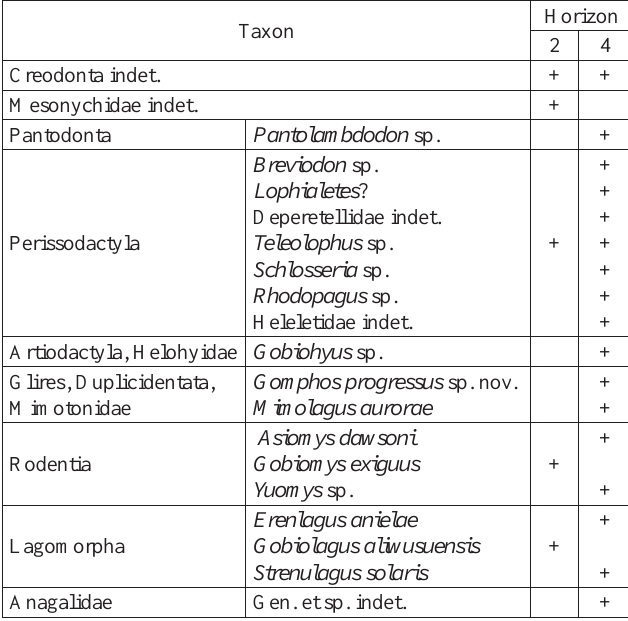
Table 1. Mammals of the Wulanhuxiu locality. Note that horizon 2 is younger than horizon